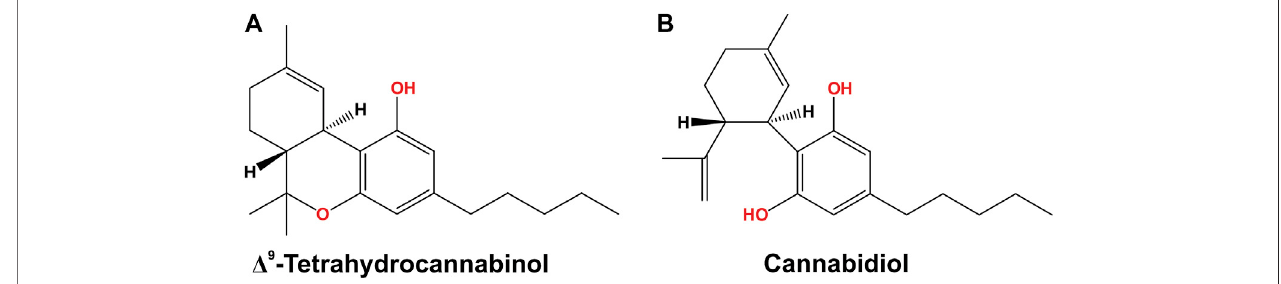
FIGURE 1 | Chemical structures, (A) THC and (B) CBD, the main phytocannabinoids extracted from the Cannabis plant THC, tetrahydrocannabinol; CBD, cannabidiol.